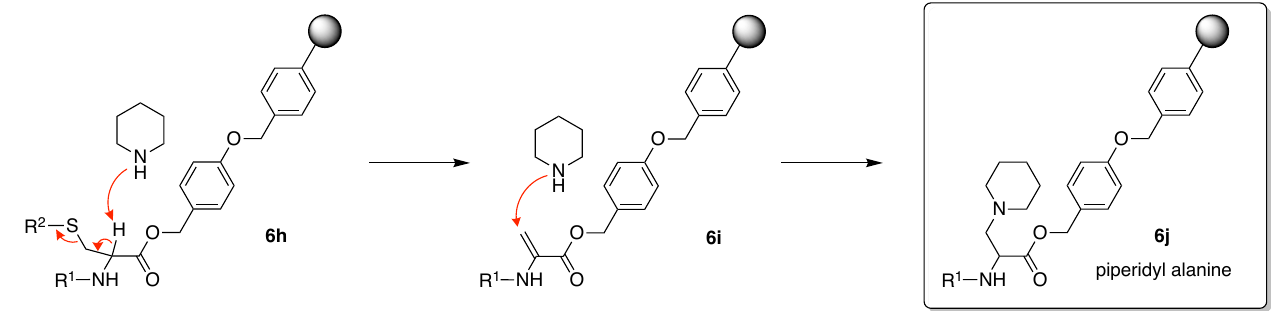
Figure 12. β-Elimination of Cys-Wang resin during Fmoc deprotection (with piperidine) on SPPS. Figure 12. β -Elimination of Cys-Wang resin during Fmoc deprotection (with piperidine) on